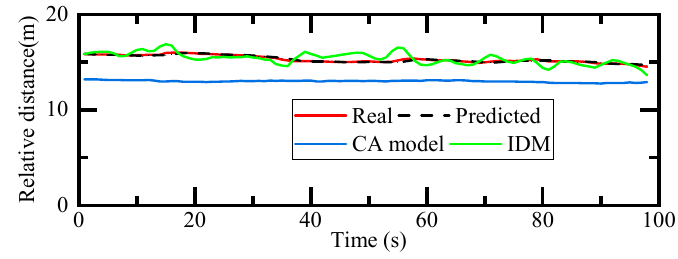
Figure 7. Results when following a passenger car.